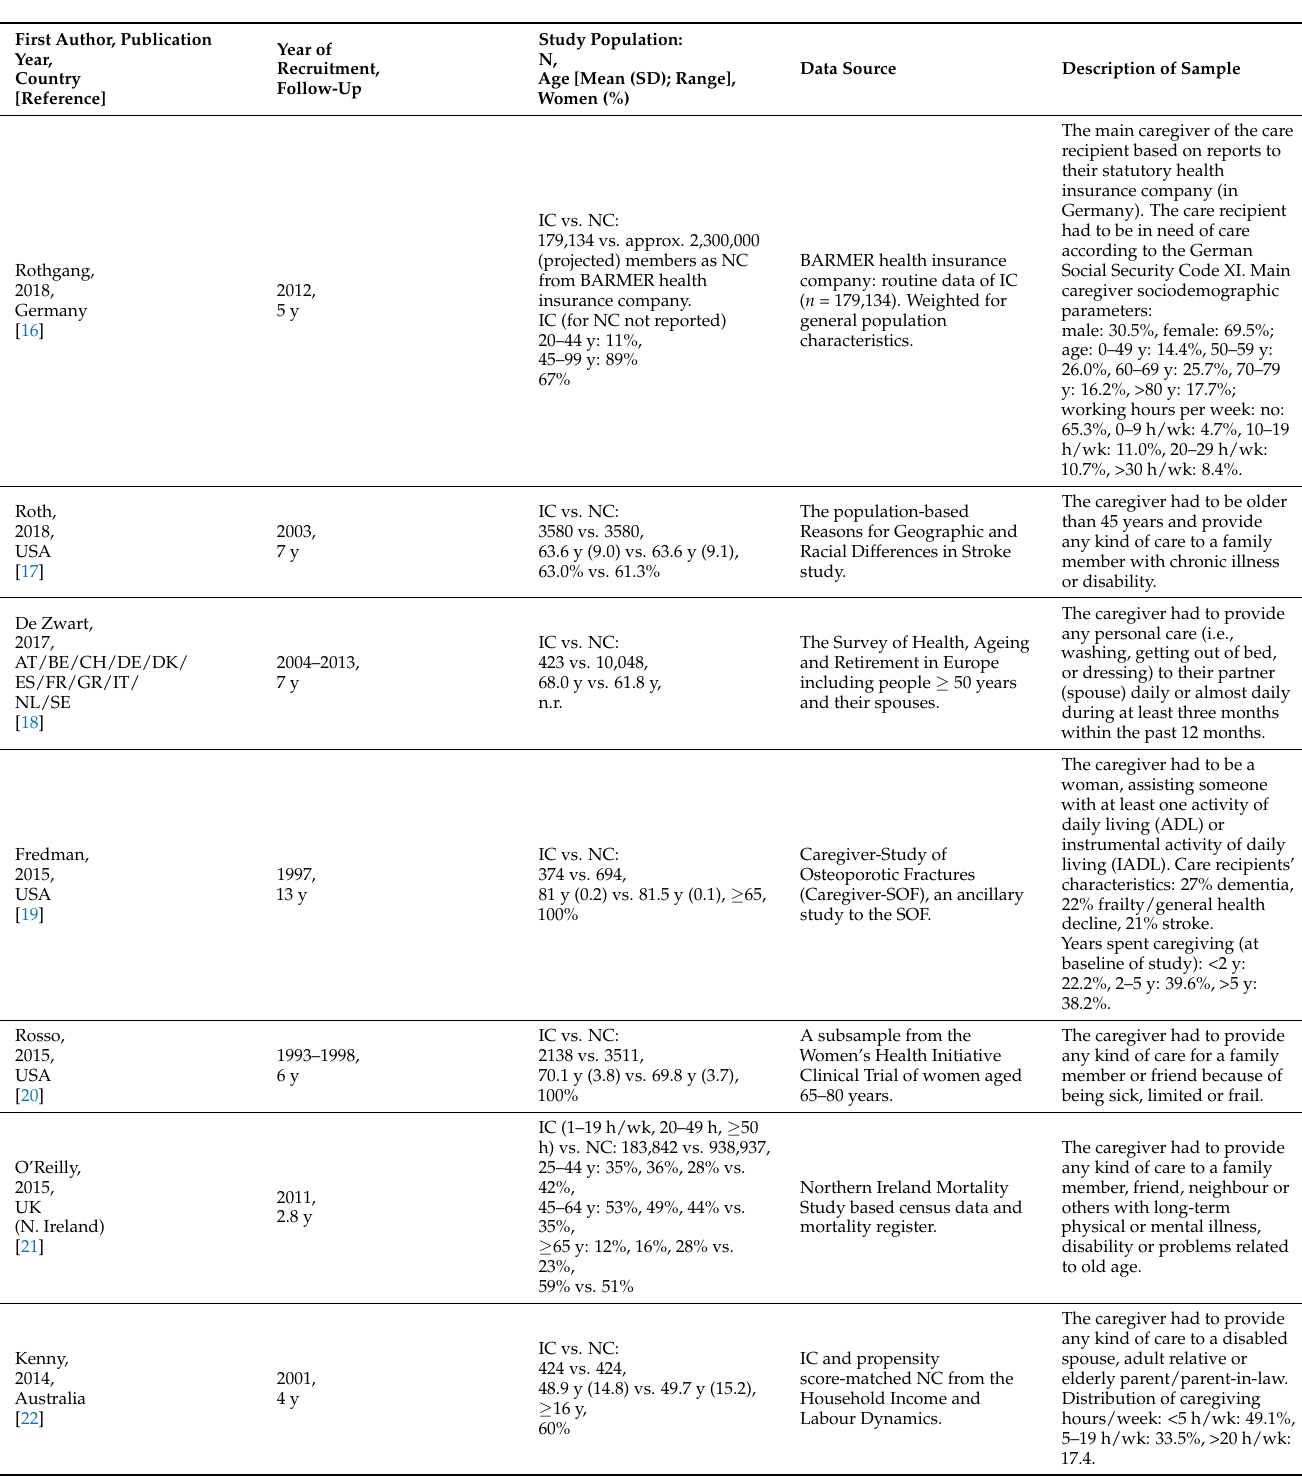
Table 1. Basic characteristics of longitudinal studies comparing occurrence of diseases/disorders between informal caregivers (IC) and non-caregivers